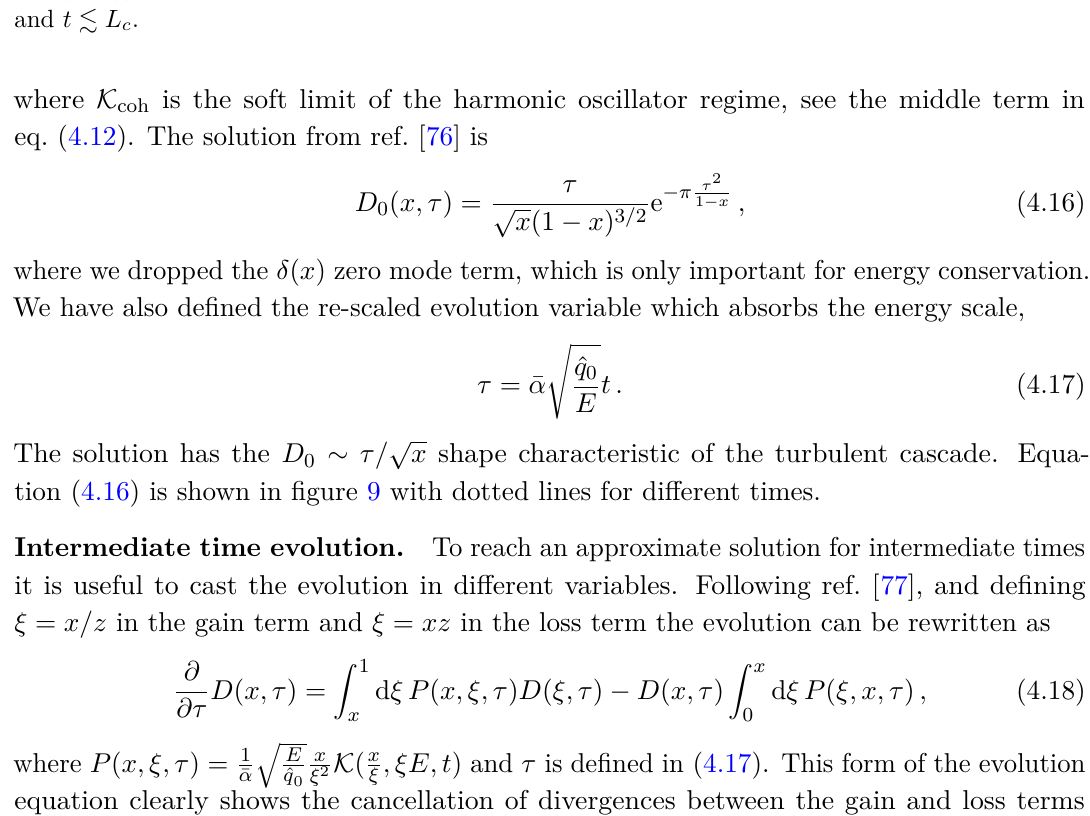
Figure 9 . Analytic solutions of the energy distribution in different approximations (eqs. (4.13), (4.16) and (4.26)). With these parameters λ = 0 . 06 fm, and thus the different panels are t < λ , λ < t < L c , and t . L c